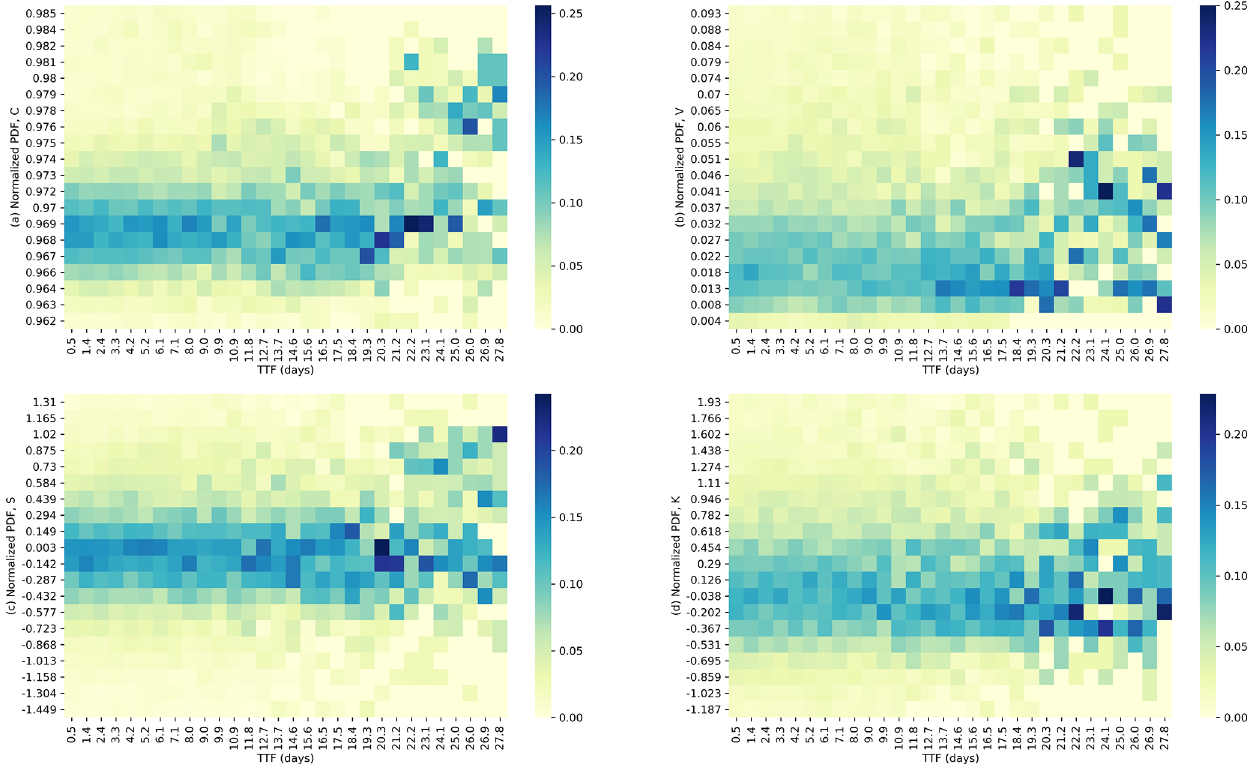
Figure 2. Heatmaps of normalized probability density functions of C , V , S , and K at different times to failure (TTFs), for the east–west component of the geoelectric TS. The TTFs are computed using M L ≥ 4 EQs within 2 ◦ longitude and latitude of the KAOH